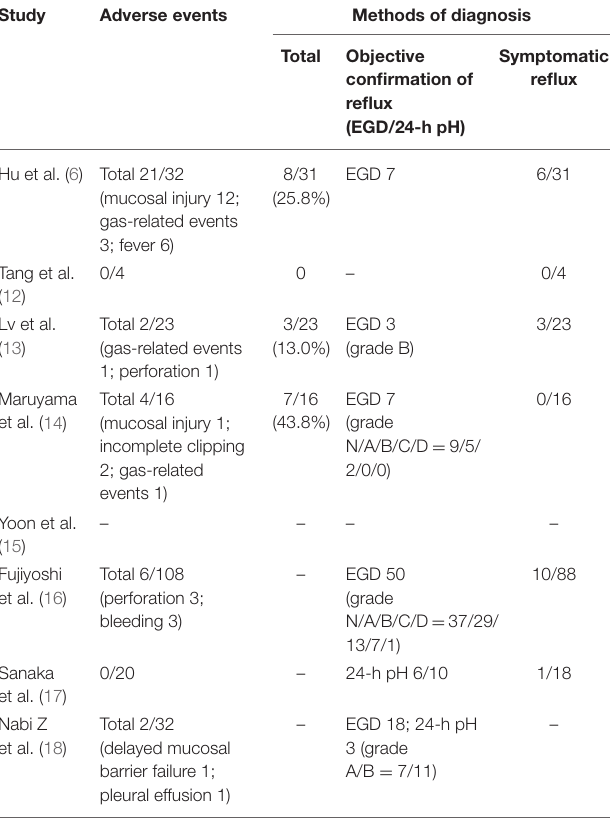
TABLE 3 | Adverse events and gastroesophageal reflux diseases after POEM. Study Methods of